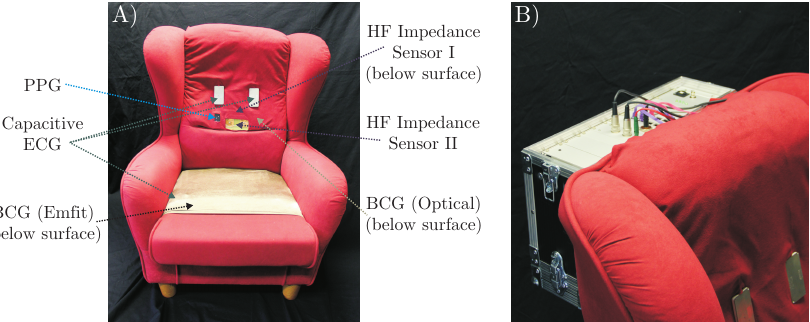
Figure 2. ( left: ) schematic of the armchair and placement of sensors, the dashed rectangular on the seat shows the placing of the EMFi sensor, while the gray rectangular illustrated the DRL electrode of the capacitive ECG. The arrows indicate the coordinate system; ( right: ) position of tracking markers and reference ECG electrodes. Modified from ([22], Figure 1) c (cid:13) 2017 IEEE.